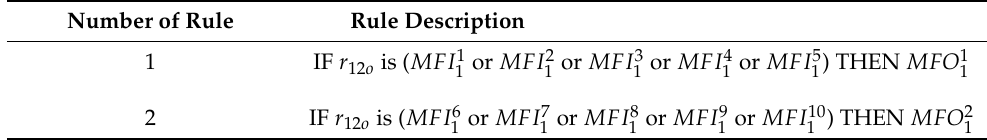
Table 1. Example of fuzzy rules of FIS1. These were defined for sensor 1.